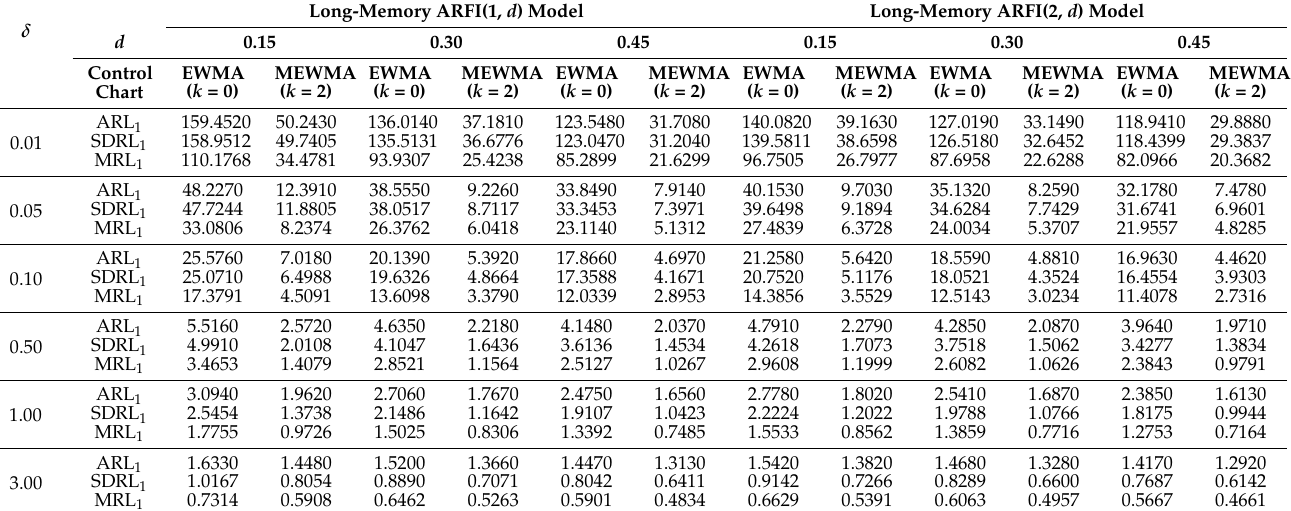
Table 8. The comparative performances of the standard and modified EWMA control charts for various shift sizes when λ =